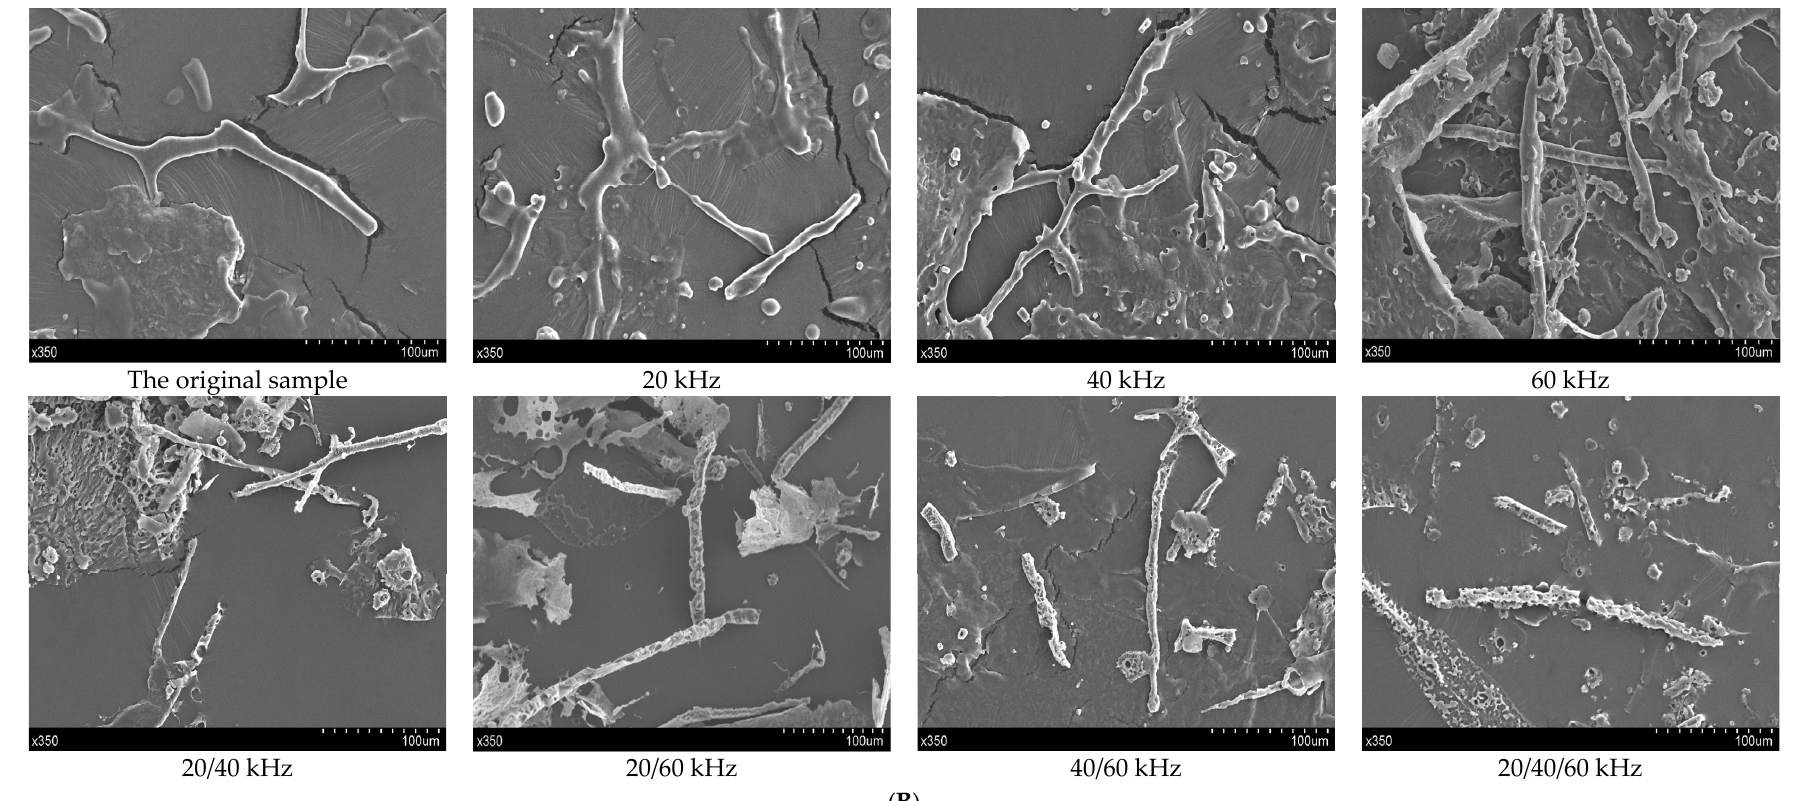
Figure 2. FT − IR spectra of lentinan in the range of 4000 − 500 cm − 1 ( A ); SEM images (350× magnification, scale bar 100 μ m) of lentinan ( B ).